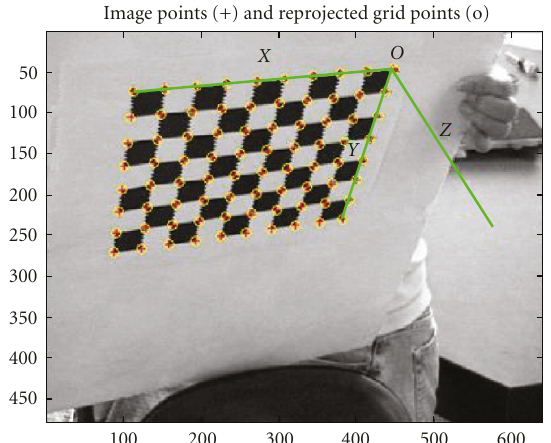
Figure 15: Example of the grid reference frame.